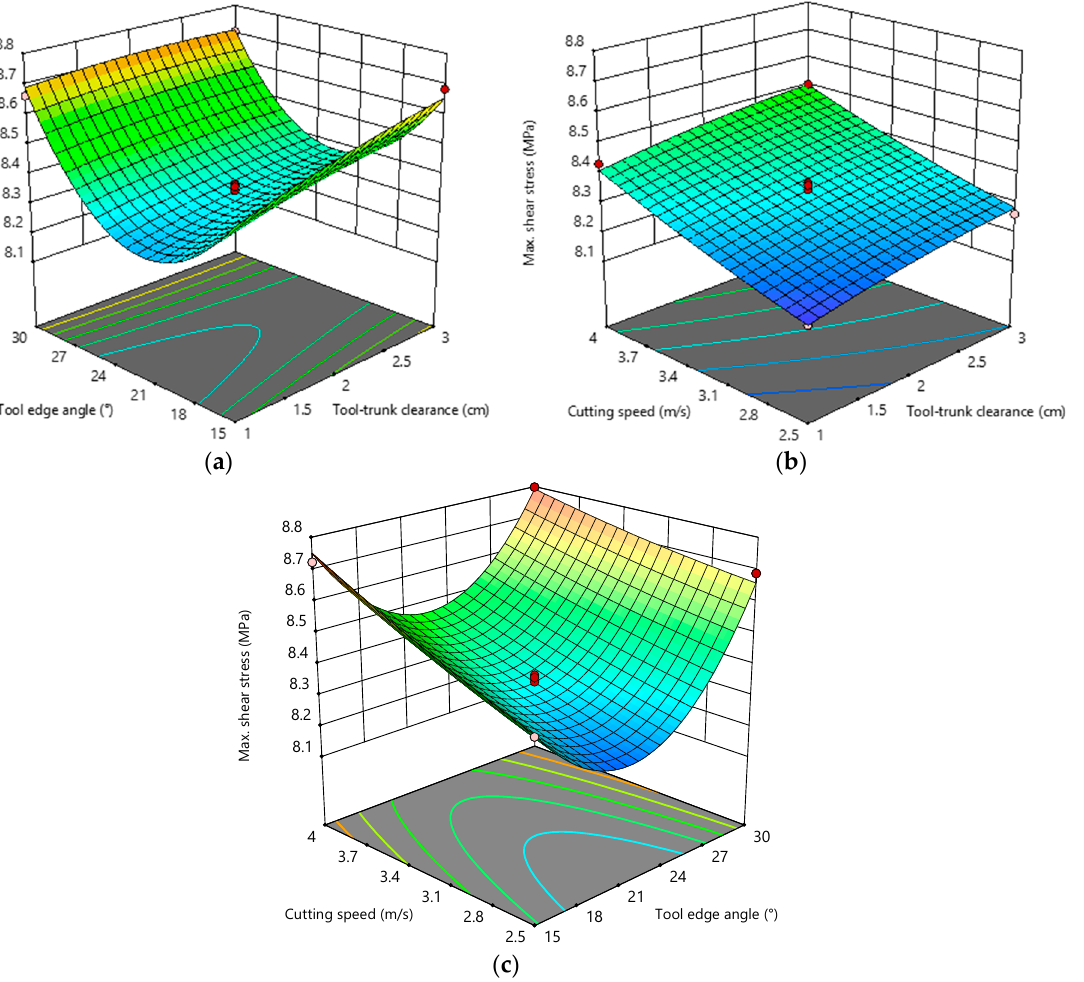
( ) σ ,3.25 f X X Figure 13. Response surface of interaction factors to maximum shear stress. ( a ) σ = f ( X ) ; 1 , X 2 ,3.25